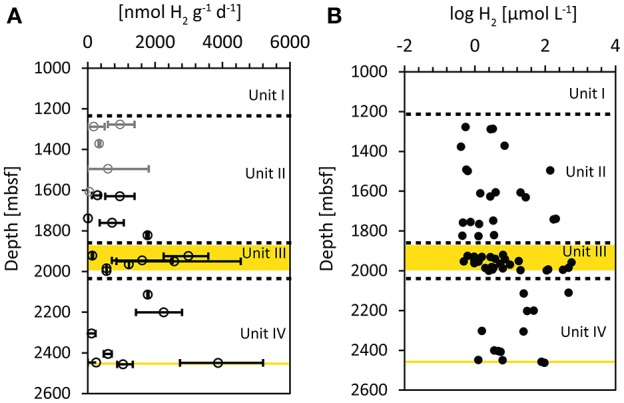
(A) Potential hydrogen oxidation rates measured by incubations with tritium gas (3H2). The error bars represent minimum and maximum values of the sample replicates, circles represent average values. Gray symbols represent samples from WRCs that were excluded from the conservative selected pSRR data. (B) Log of hydrogen concentrations in the sediment pore water, determined by the extraction method (Inagaki et al., 2015). Yellow areas represent zones with imbedded lignite layers.